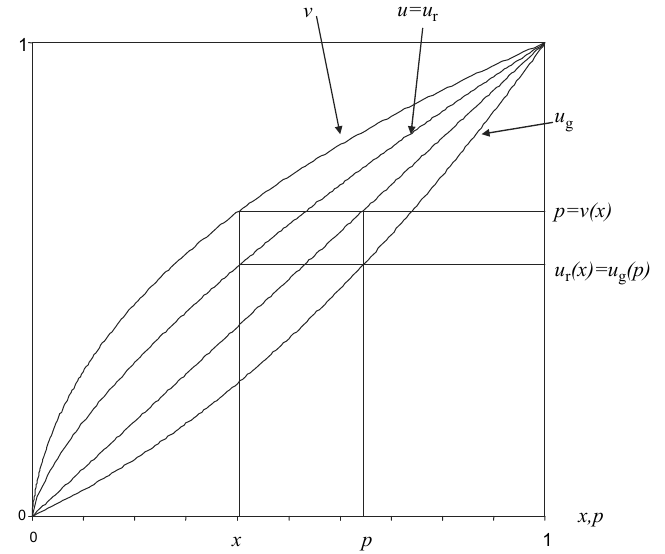
Figure 1 – Example of relevant functions for binary games in the case of risk averse behaviour. x = monetary outcome, p = probability of success for the game d ( p ) = [0,1 – p ; 1, p ], u g ( p ) = utility of the game, u ( x ) = u r ( x ) = realistic utility of x , v ( x ) = von Neumann-Morgenstern utility of x (not a realistic